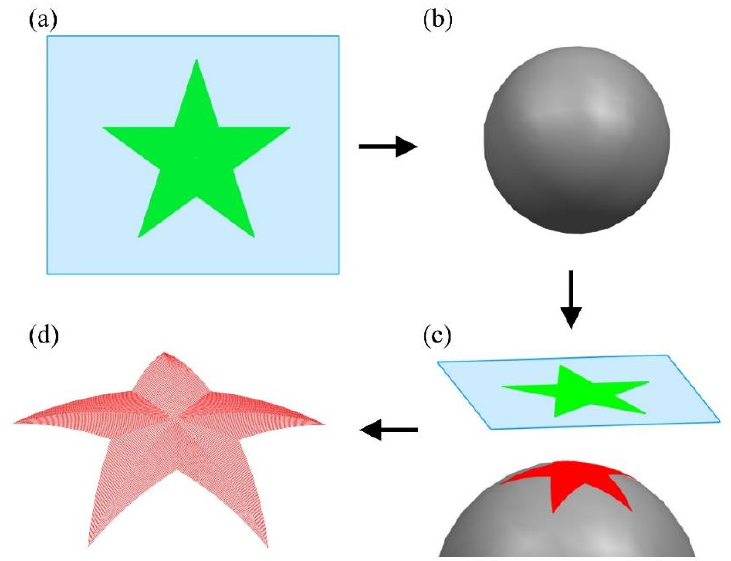
Figure 5. Projection of planar pentagonal pattern onto spherical surface. ( a ) Planar pentagonal pattern; ( b ) spherical surface; ( c ) projection by equal arc length algorithm; ( d ) projected non-planar pentagonal pattern.